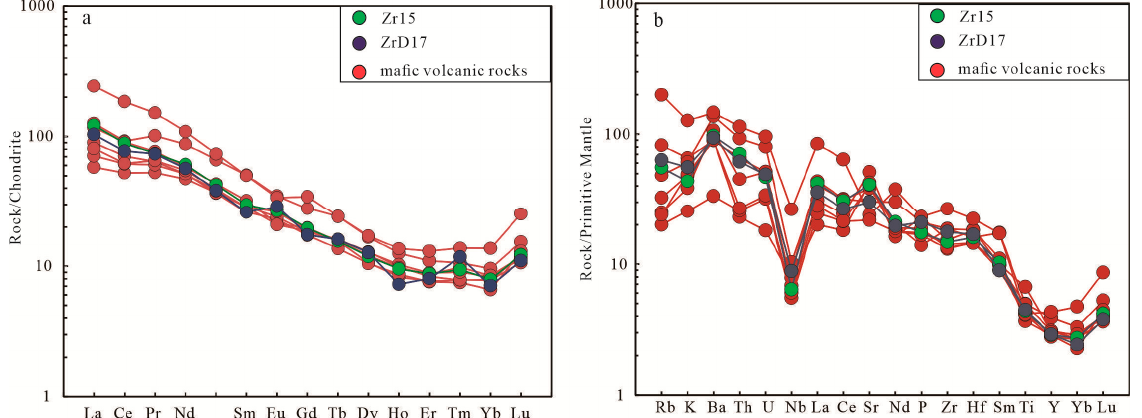
Figure 6. Chondrite-normalized REE patterns ( a ) and primitive-mantle-normalized trace element spider diagrams ( b ) for the Late Jurassic mafic volcanic rocks in Badaguan area (modified after Sun et al. [42]).